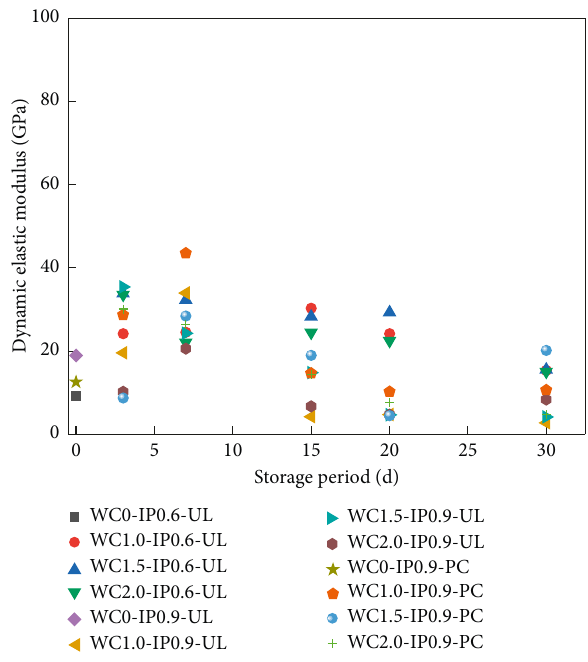
Figure 12: Dynamic elastic modulus of ready-mixed concrete. The coordinates of the dynamic elastic modulus axis is modified to 0–50 GPa and divided into five parts in units of 10